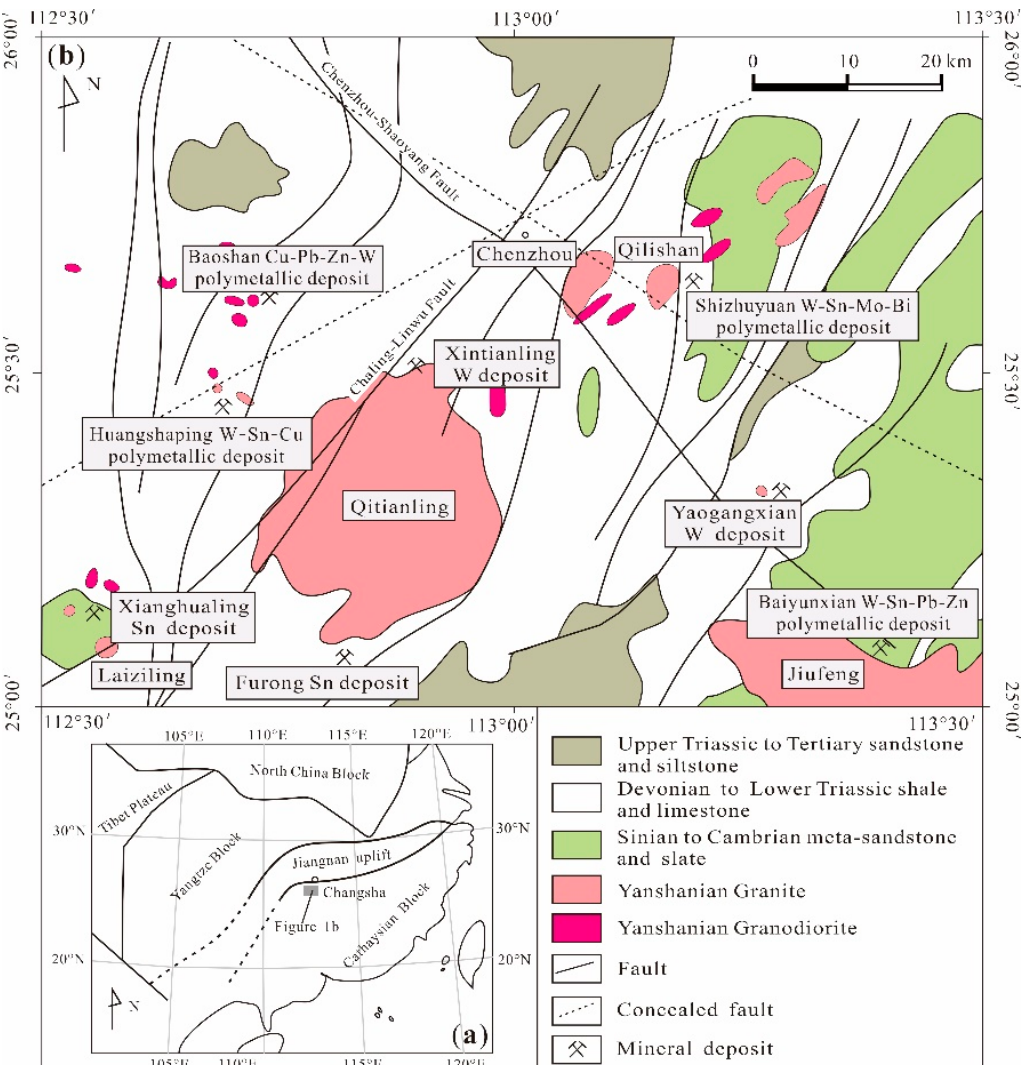
Figure 1. Regional geology of the central Nanling region and the location of the Xianghualing skarn Sn deposit, southeastern China (modified after [6,30]). ( a ): Tectonic map of South China, showing the location of southern Hunan Province; ( b ): Geological map of southern Hunan Province, showing the distribution of intrusive rocks and major W–Sn deposits.